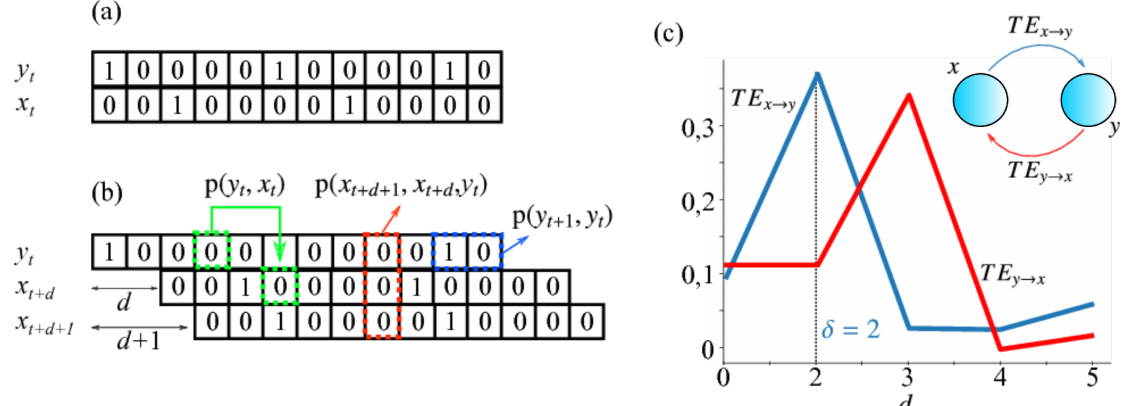
Figure 2. Method to measure the delayed transfer entropy using the joint probability distributions. ( a ) First, we take two spike-trains of a pair of neurons in the network. ( b ) Then, we apply a delay d in one of them to determine the joint probability distributions p ( x t , y t ) (indicated by the green arrow), p ( x t + 1 + d , x t + d , y t ) (indicated by the red arrow), and p ( y t + 1 , y t ) (indicated by the blue arrow). Next, we estimate the transfer entropy by inserting these distributions into Equation (10). ( c ) Example plots of TE y → x and TE x → y for a simple system of two coupled neurons (shown in the inset) with x → y connection delay δ x → y = 2 and y → x connection delay δ y → x = 3. The respective TE s are maximized when the measure delay d is the same as the corresponding connection